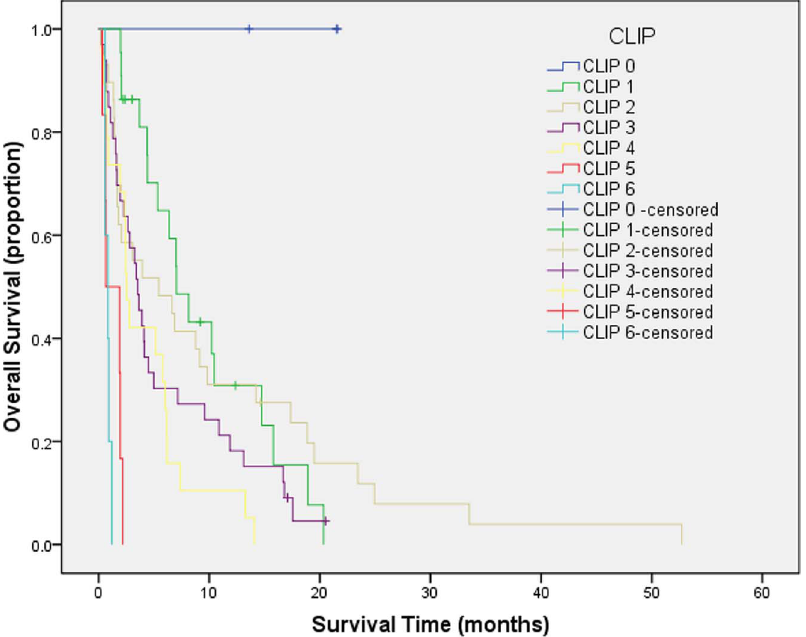
Figure 4. Survival curves for patients with unresectable hepatocellular carcinoma who stratified according to the Cancer of the Liver Italian Program staging system. Score 0 versus 1, P=.050; score 1 versus 2, P=.056; score 2 versus 3, P=.412; score 3 versus 4, P=.518; score 4 versus 5, P=.033; score 5 versus 6, P=.464. No statistical differences were noted between any scores.